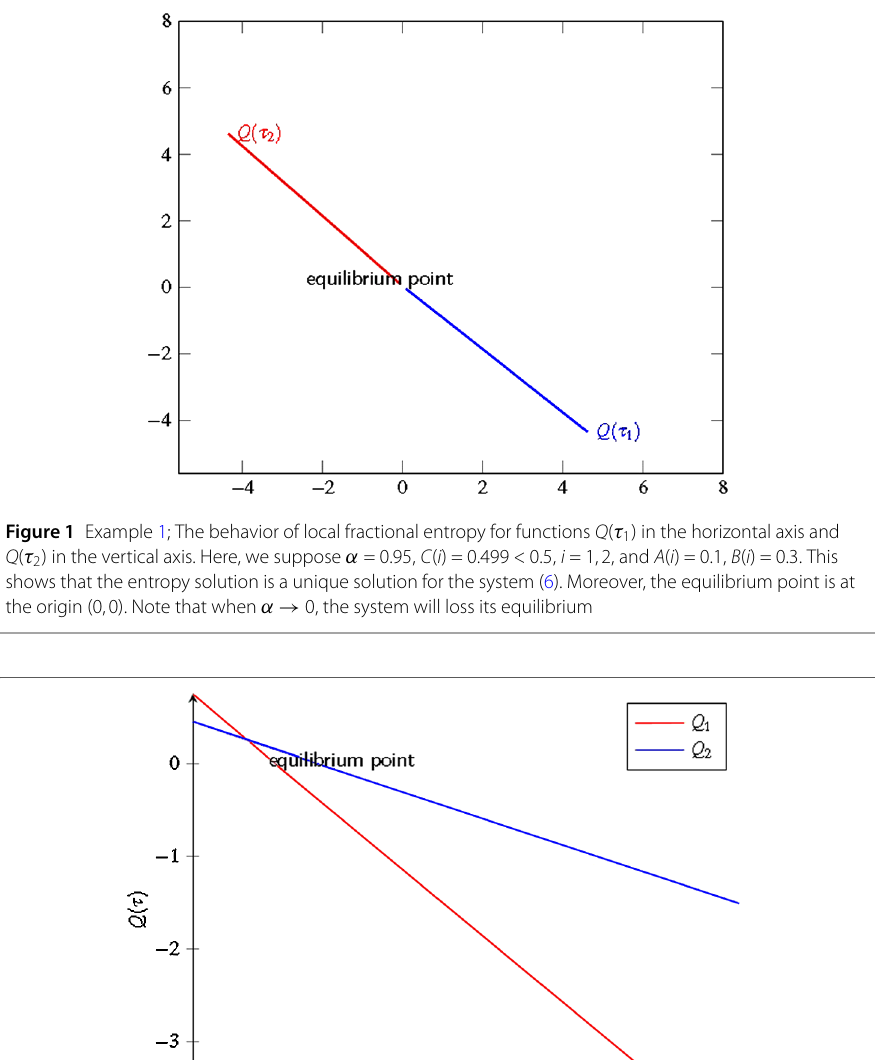
replaying to the quantity. Consequently, we have the system (see Fig. 2)